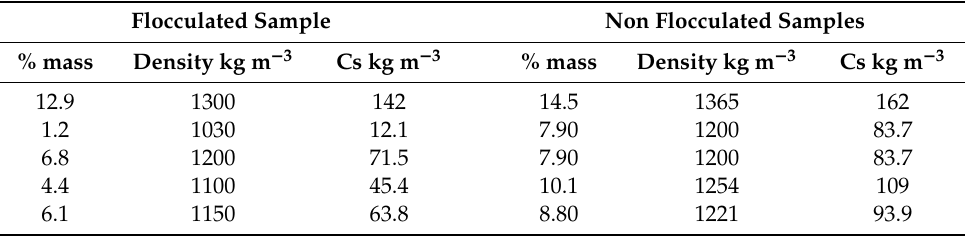
Table 1. Solid content and density of the samples taken from the Occhito